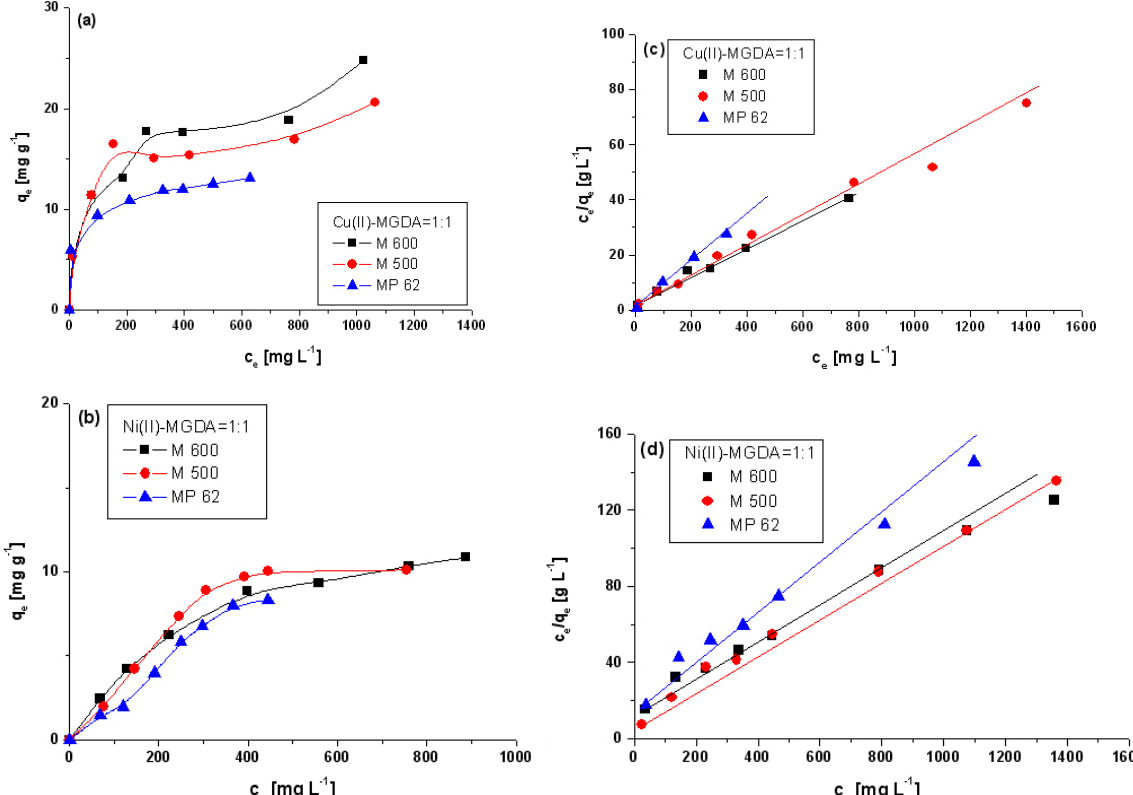
Figure 5. The sorption isotherms of Cu(II)-MGDA (a) and Ni(II)-MGDA (b) complexes on Lewatit MonoPlus M 600, Lewatit MonoPlus M 500 and Lewatit MP 62 as well as the Langmuir isotherm plots for Cu(II)-MGDA (c) and Ni(II)-MGDA (d) complexes.